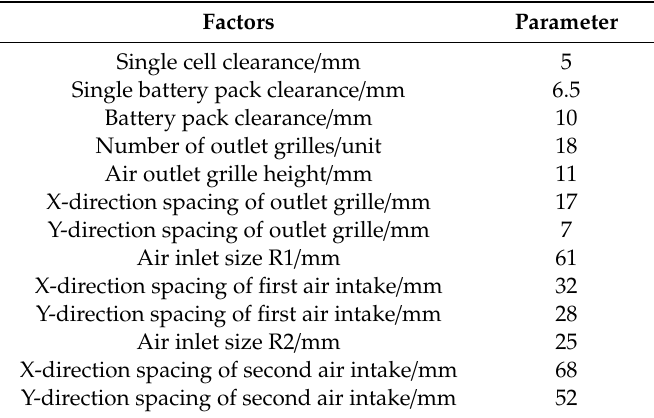
Table 5. Optimal scheme